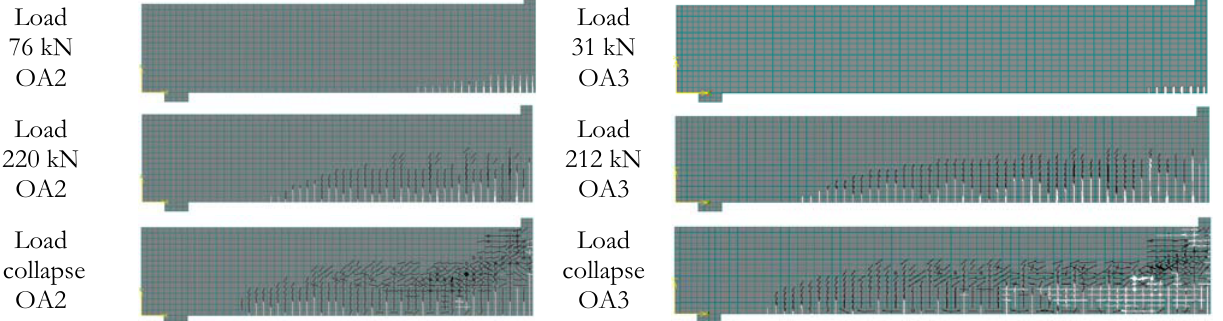
Figure 6: Failure in a beam. OA2 (left) and OA3